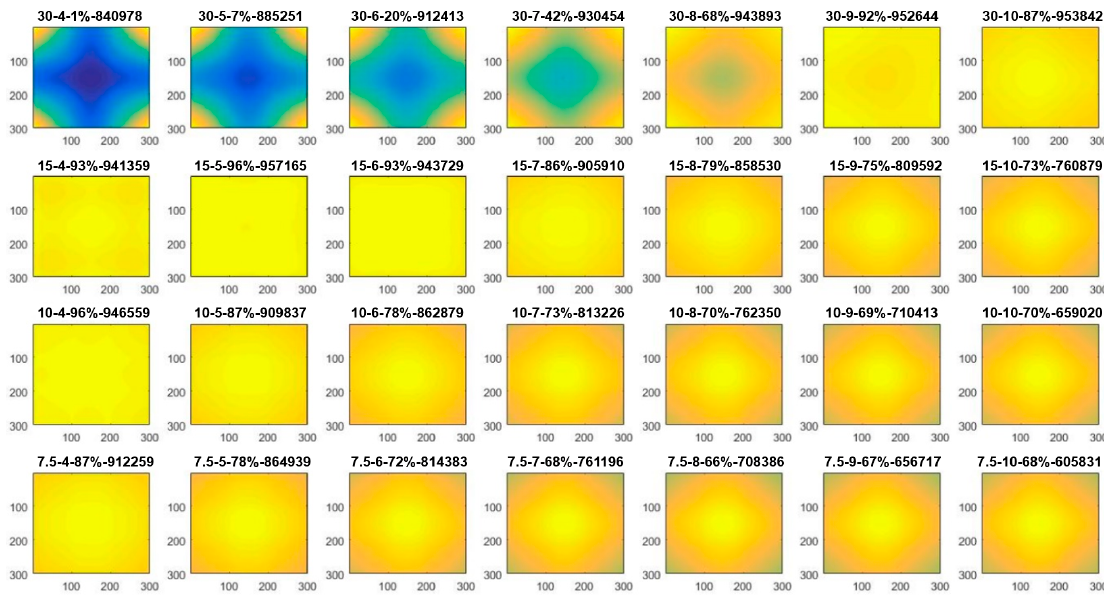
Figure 7. Array analysis of FDCSP.